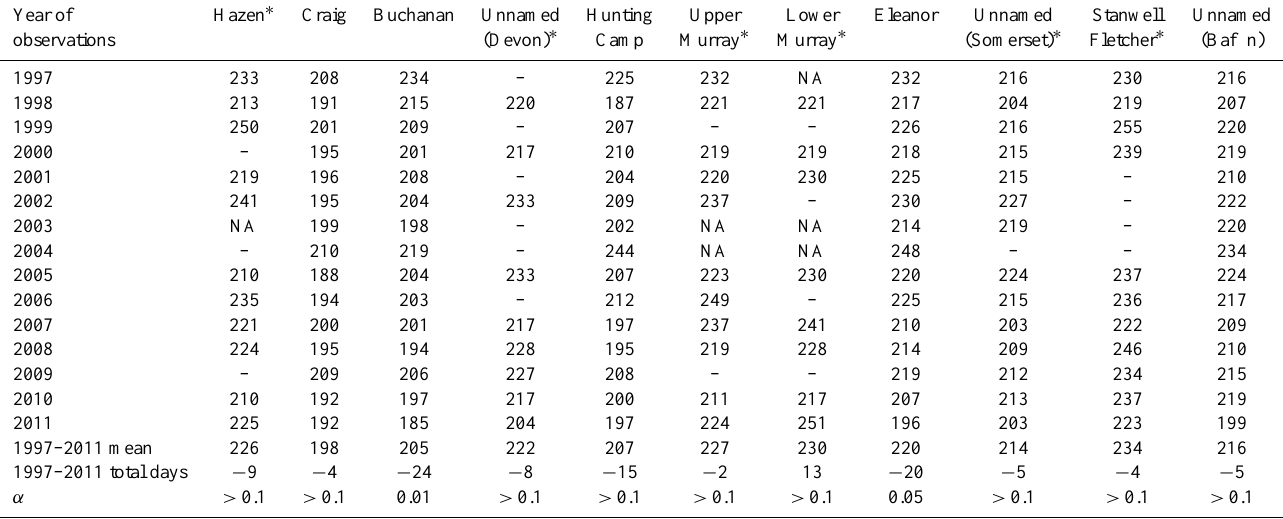
Table 5. Water-clear-of-ice dates shown as day of the year (DOY) for the studied lakes from 1997 to 2011. Missing values (NA) indicate the lack of available imagery. Dash indicates that complete melt did not occur. Asterisks indicate the lakes that maintained an occasional perennial ice. Total days for each individual lake refer to the total number of days change during the 1997–2011 period and are reported to the mean water-clear-of-ice DOY of the same period. The statistical significance is indicated by the α